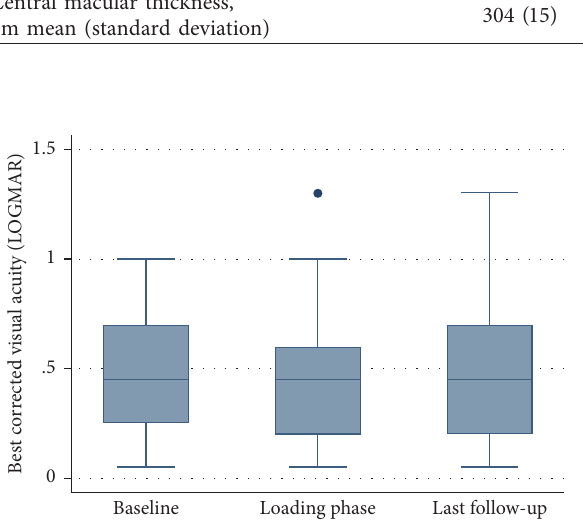
Figure 1: Boxplot analysis illustrates best corrected visual acuity in the eyes at the analyzed timepoints. The ordinate shows best corrected visual acuity (logMAR) at baseline prior to treatment switch (left side), after the loading phase which is three injections of bevacizumab (middle), and at last available follow-up visit (right side) shown on the abscissa. Statistically significant results (pair- wise comparison Wilcoxon test, p < 0 . 05) are marked with an asterisk.